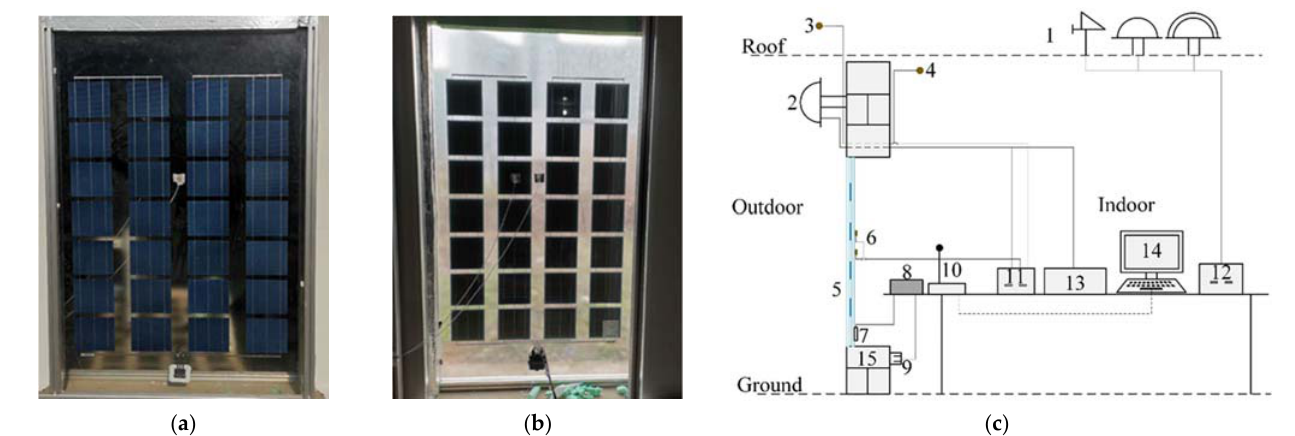
Figure 3. ST-PVW experimental platform and measuring point layout: ( a ) ST-PVW outside; ( b ) ST-PVW inside; ( c ) Schematic diagram of measuring point layout, 1. Outdoor weather stations. 2. Wall irradiance sensors. 3. Outdoor temperature sensors. 4. Indoor temperature sensor. 5. Photovoltaic glass window. 6. Thermal resistance temperature probe. 7. Photovoltaic module wiring port. 8. Microinverters. 9. Inverter grid interface. 10. Inverter signal receivers. 11. Data recorders. 12. Meteorological data recorder. 13. Regulators. 14. Computers. 15. Building walls. Table 1. Simulation input parameters of